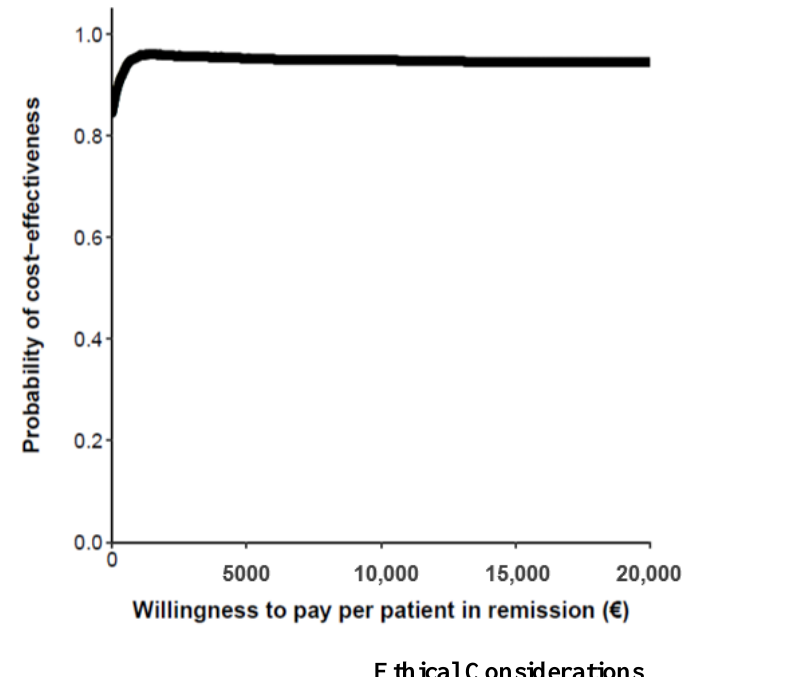
Figure 2. Cost-effectiveness acceptability curve representing the probability that one intervention is cost-effective relative to another, depending on the willingness-to-pay